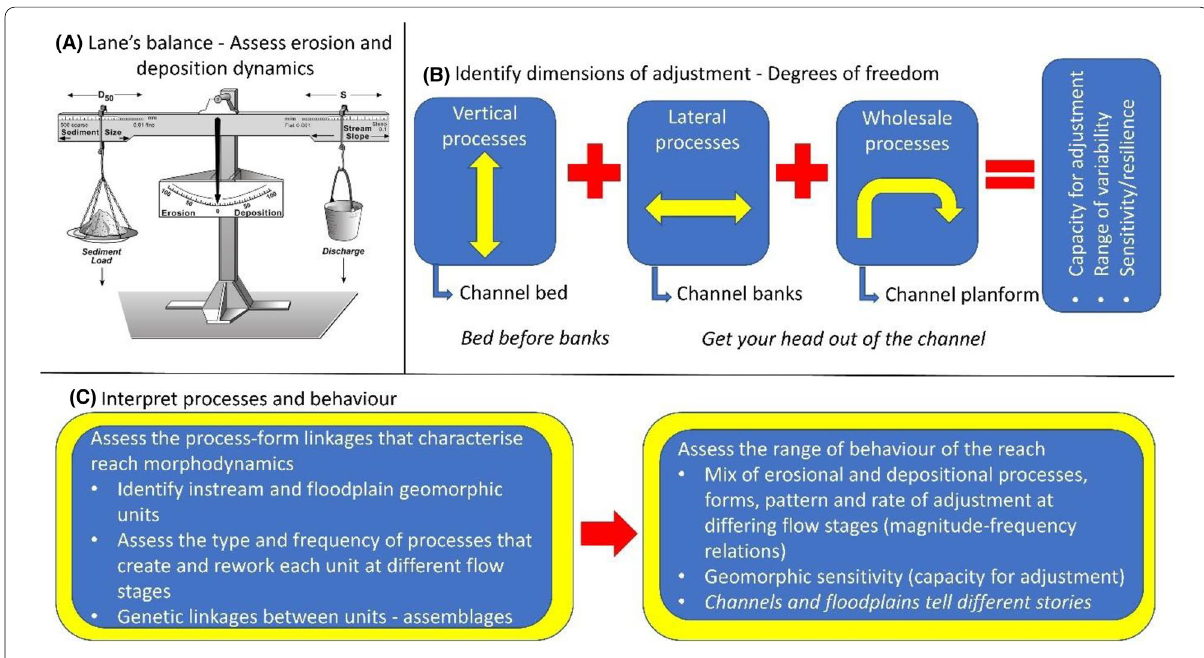
Fig. 4 Process–form linkages of geomorphic units determine and reflect river morphodynamics (and resulting channel geometry/planform) at the reach scale. A Lane Balance diagram helps to assess the balance of erosion and deposition at the reach scale. B Dimensions of adjustments and degrees of freedom determine the capacity for a river to adjust, its sensitivity and its range of variability. C Process–form associations of geomorphic units at different flow stages help to interpret river